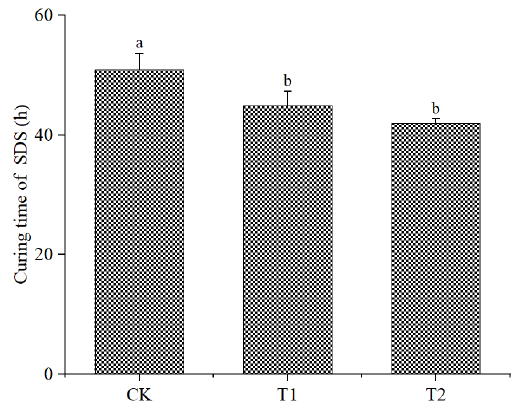
Figure 1. Comparison of time of the stem-drying stages under different treatments. Table 2. Comparison of curing energy consumption costs under different